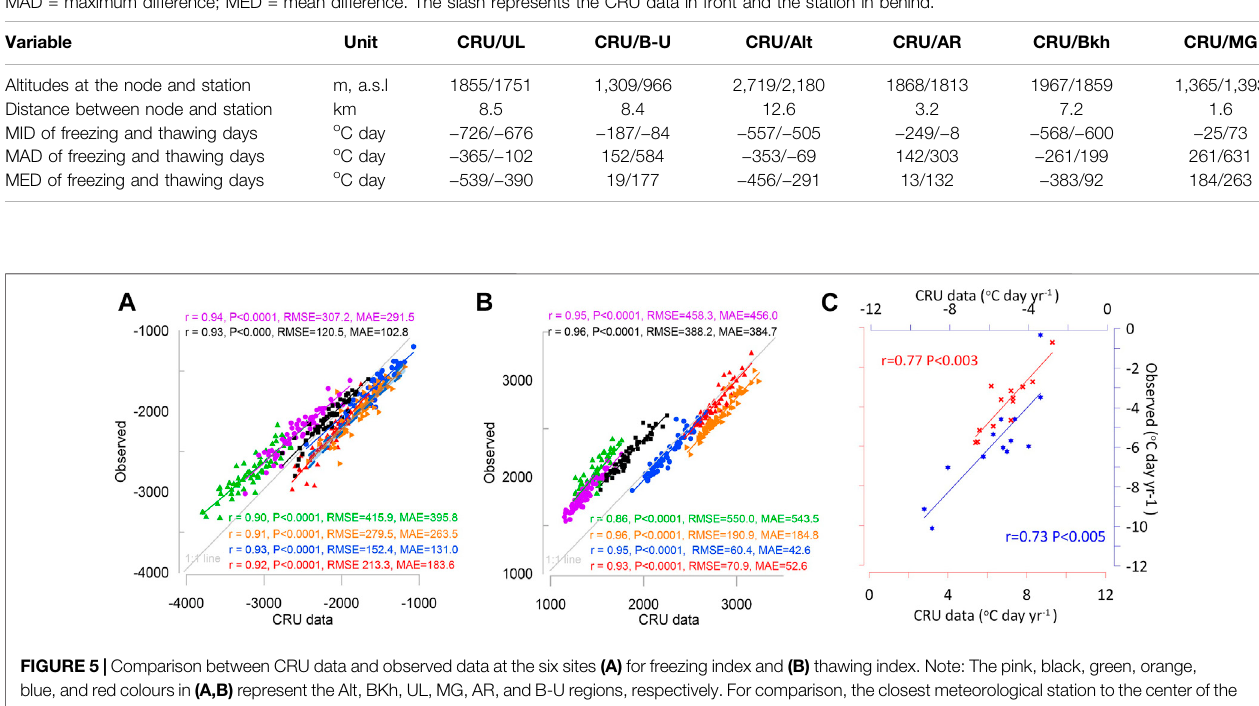
Frontiers in Earth Science |